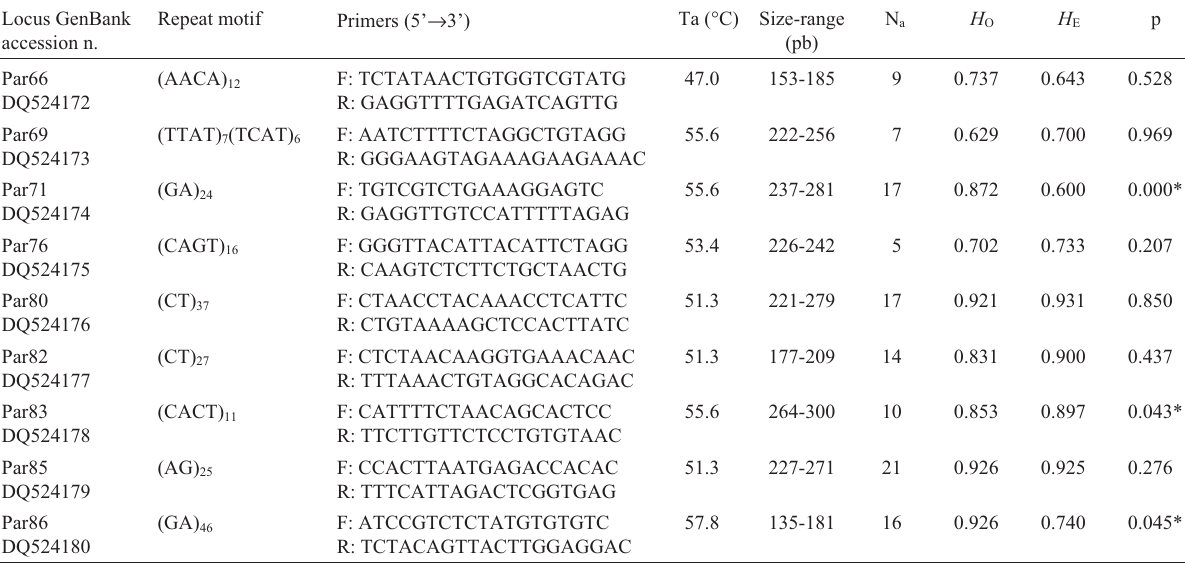
Table 1 - Characterization of microsatellite loci in Prochilodus argenteus . Locus GenBank accession